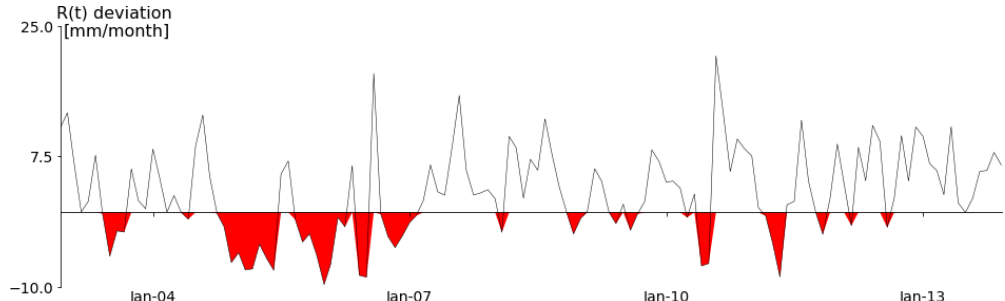
Figure 12. Deviation from the threshold value of monthly groundwater recharge. The red color represents groundwater drought events on recharge.